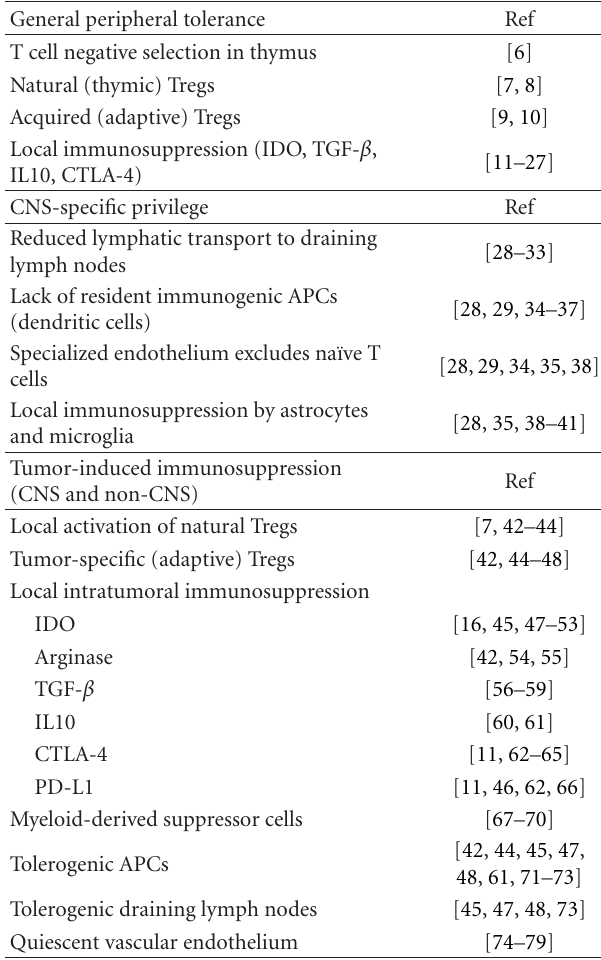
Table 1: Mechanisms of immune